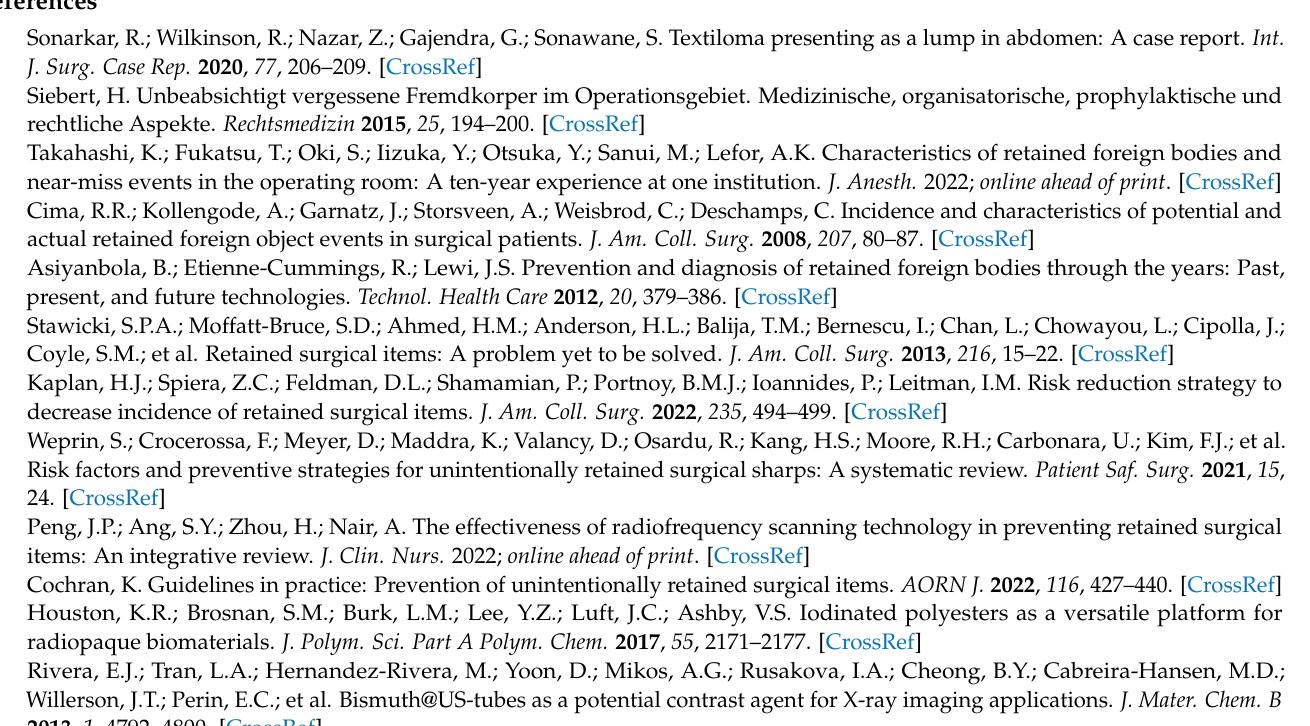
Figure S5: A comparison of phase angles tan δ of pure PVC and all four